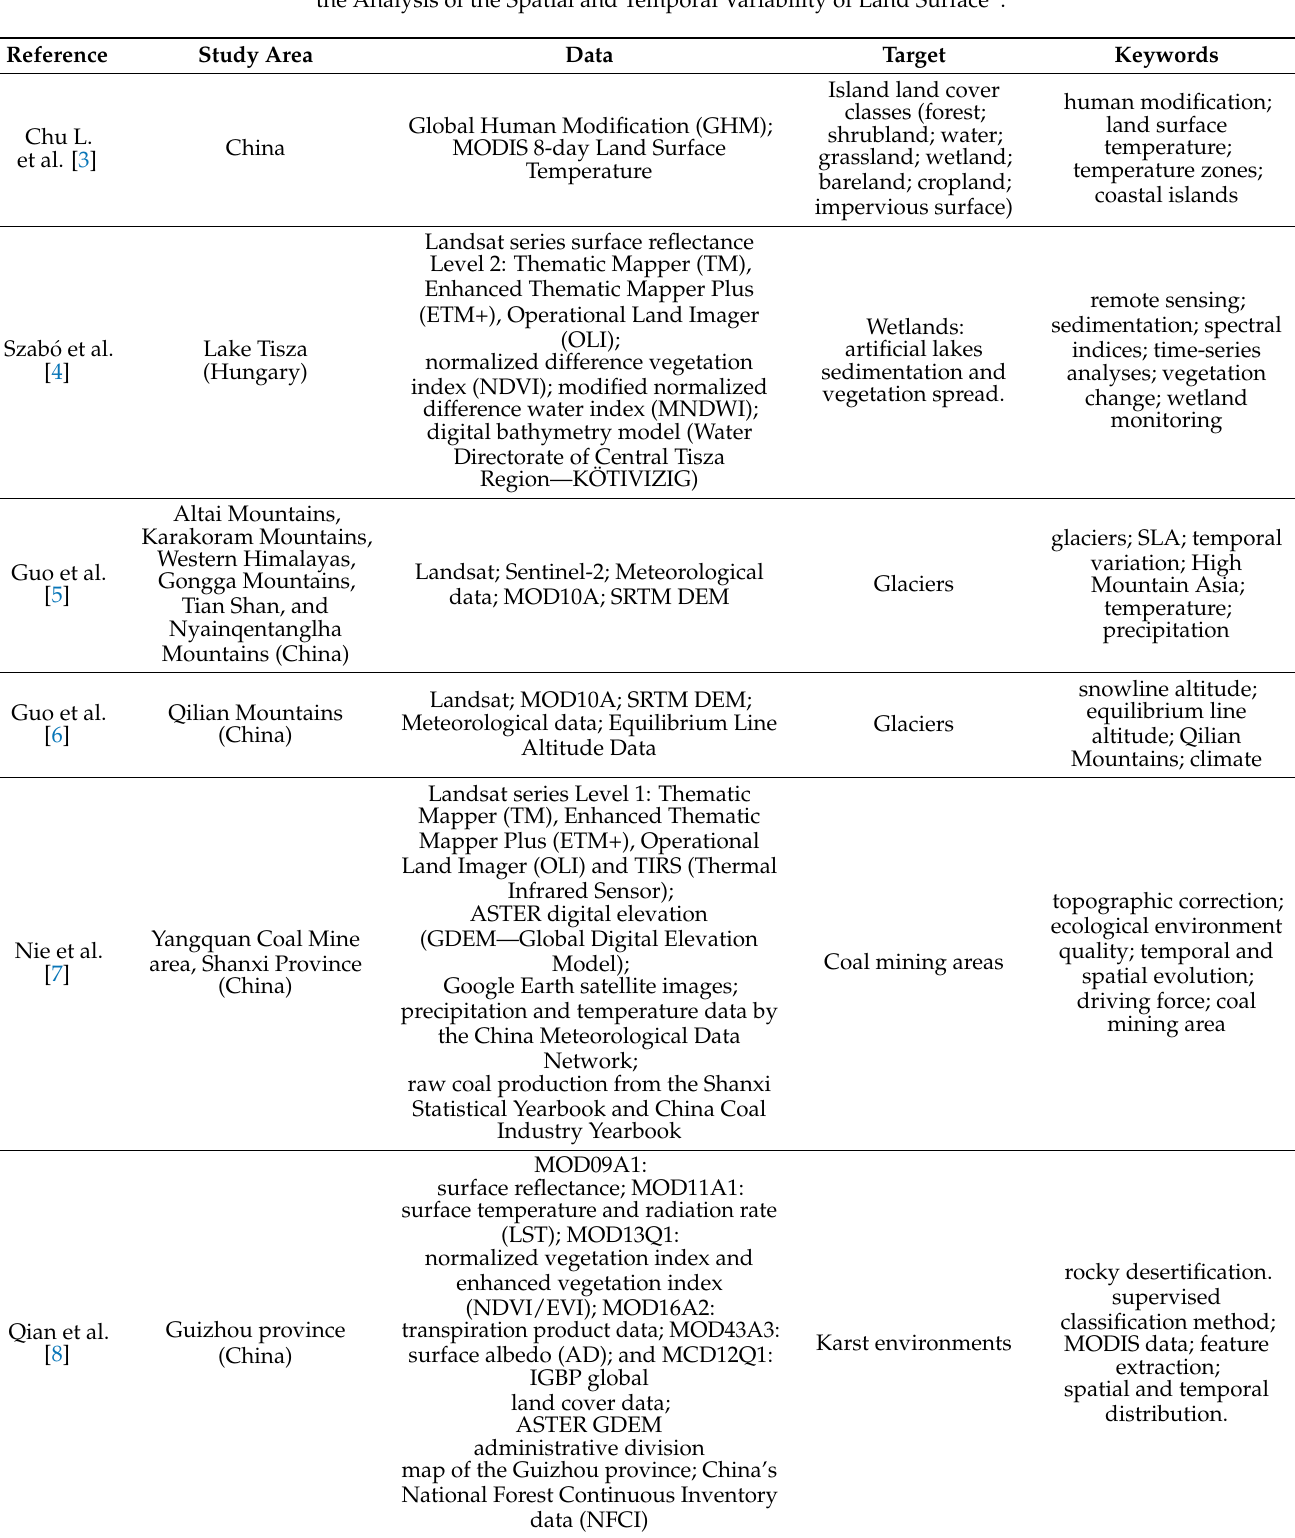
Table 1. Main features of the contributions in the Special Issue on “Advances of Remote Sensing in the Analysis of the Spatial and Temporal Variability of Land